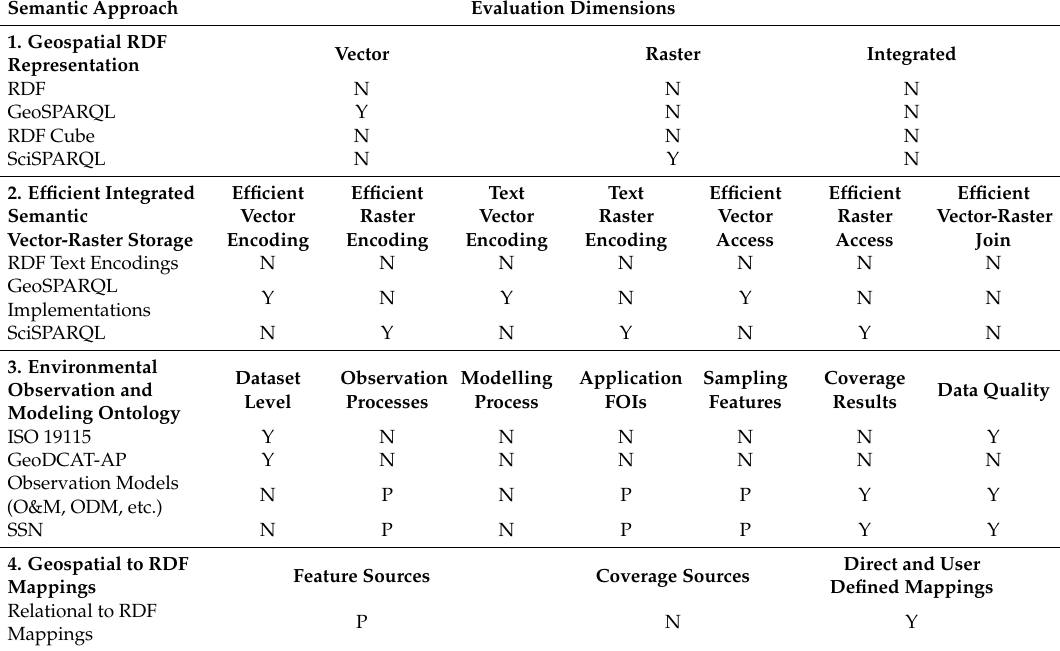
Table 1. Evaluation of current semantic technologies in the context of each research challenge. Semantic